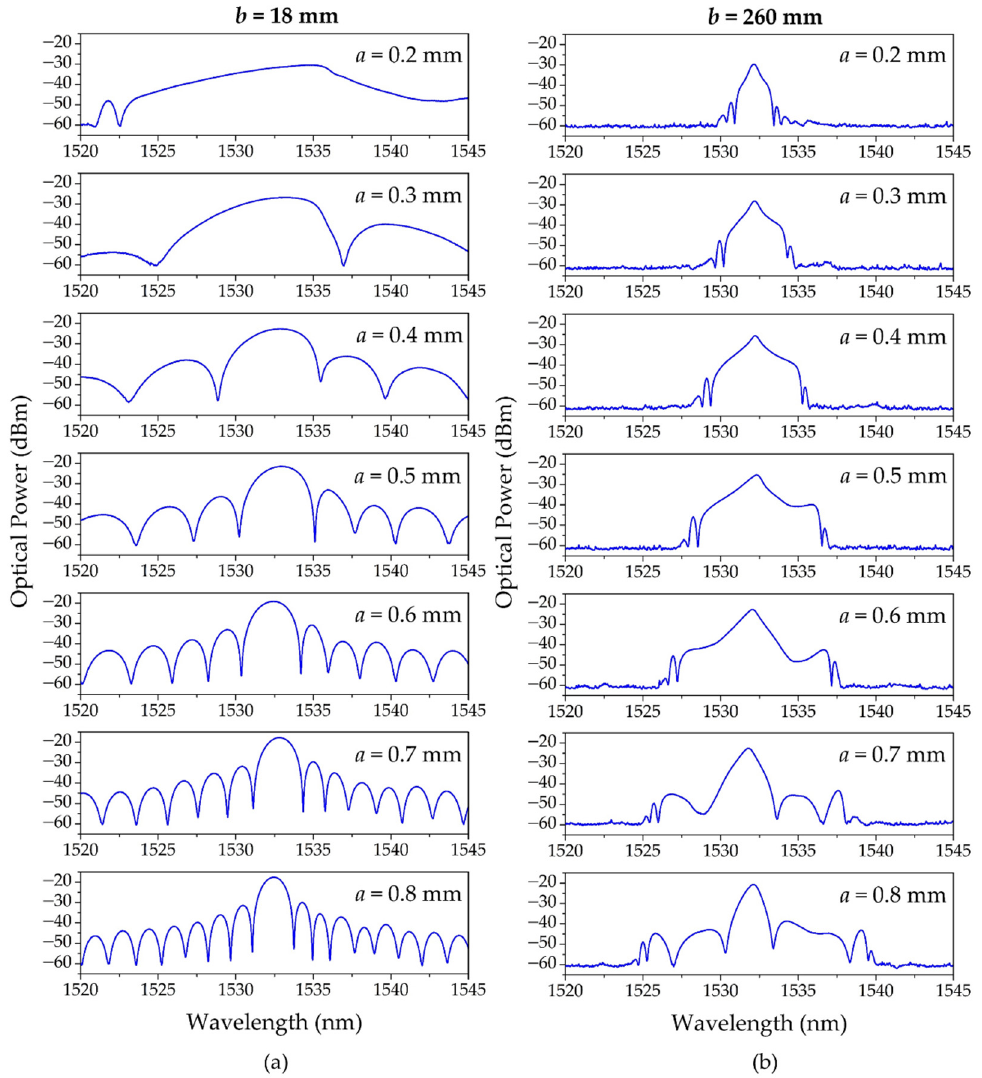
Figure 4. Reflected spectra of the produced USFBGs with different slit widths when: ( a ) b = 18 mm; ( b ) b = 260 mm.